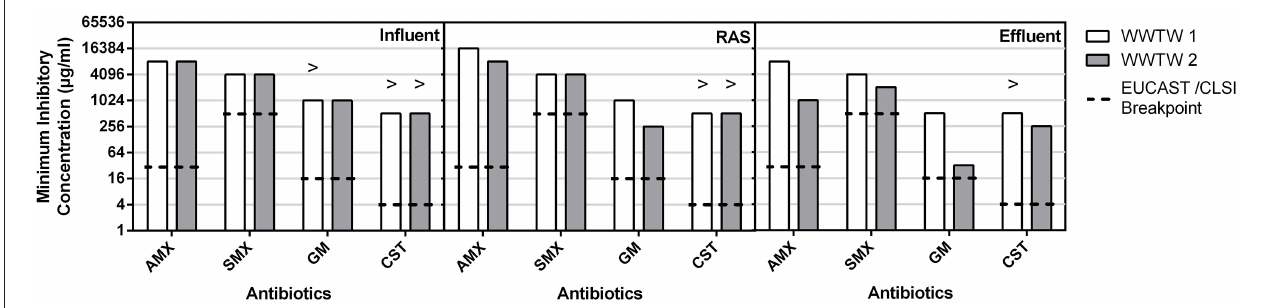
FIGURE 6 | The MICs of whole communities in influent, RAS, and effluent samples from two WWTW for AMX, SMX, GM and CST. The greater than symbol ( > ) indicates growth still occurred in the highest concentrations used and as a result the MIC is greater than the value depicted by the bar.